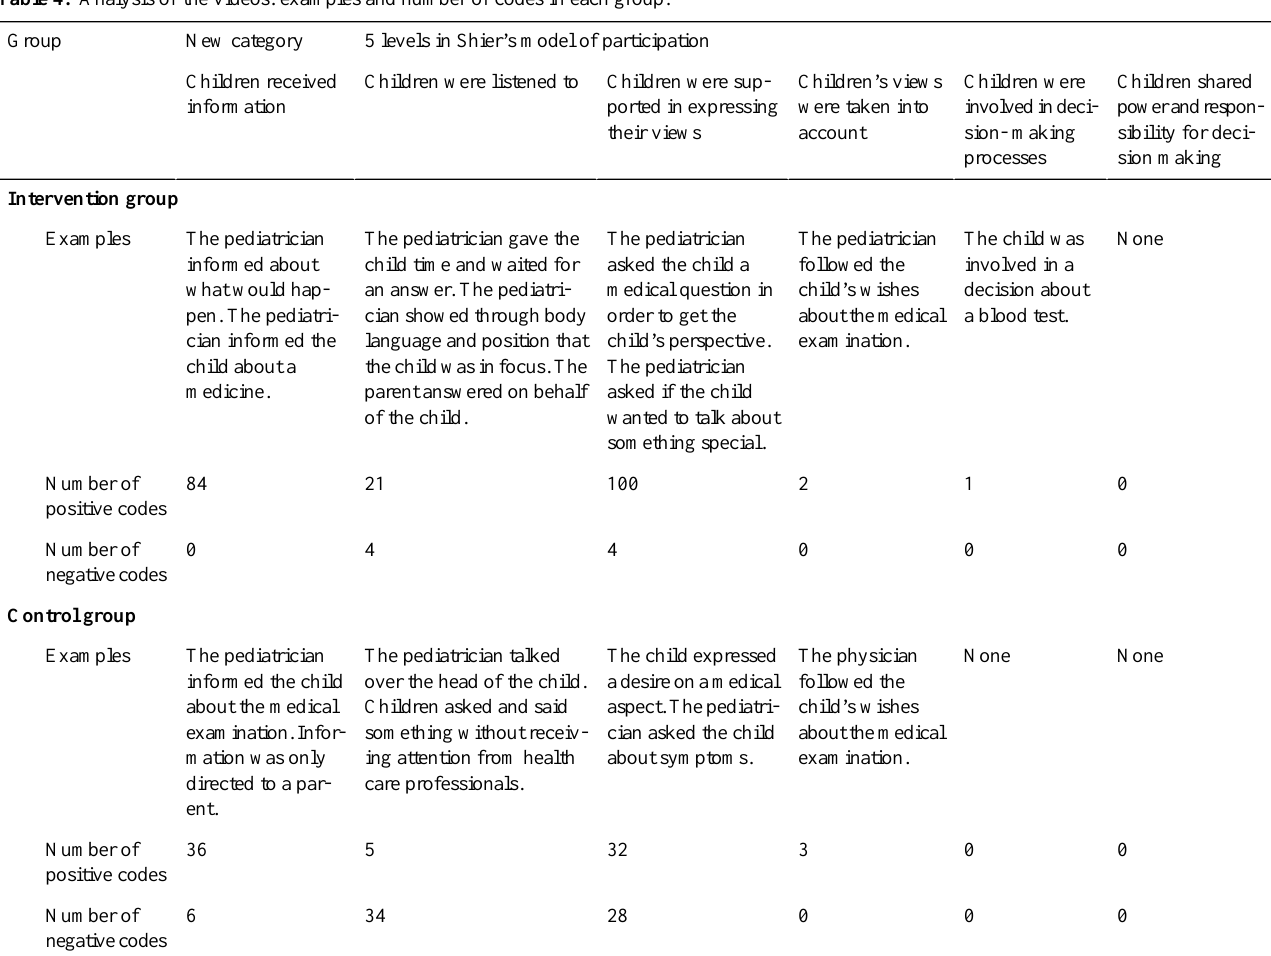
Table 4. Analysis of the videos: examples and number of codes in each group.